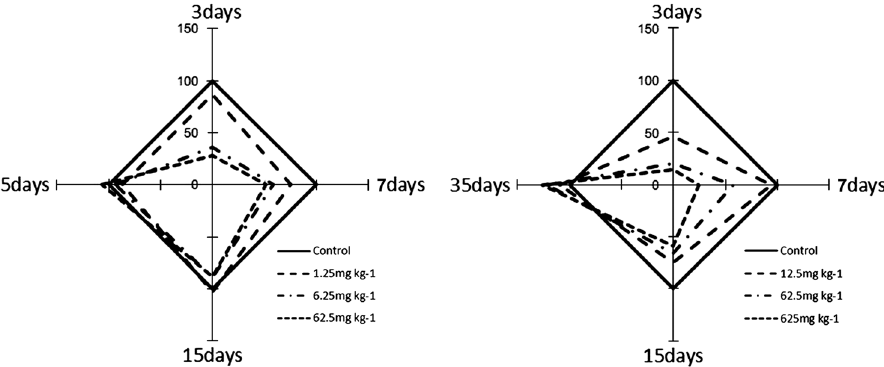
Figure 3. Effect of cantharidin (at 1.25, 6.25 and 62.5 mg kg − 1 DW soil) and norcantharidin (at 12.5, 62.5 and 625 mg kg − 1 DW soil) on diversity of fungal population (as reflected by the H ’ from PCR-DGGE). At each incubation time, values of H ’ without pesticide treatment was used as reference samples (set to